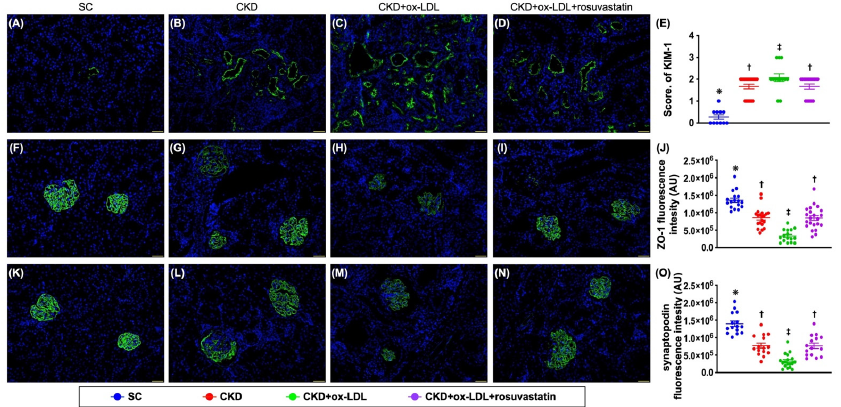
Figure 10. The histopathological analyses of kidney injury molecule and podocyte components in kidney parenchyma by day 42 after CKD induction. ( A – D ) Illustrating the immunofluorescent (IF) microscopic finding (200×) for identification of cellular expressions of kidney injury molecule (KIM)- 1 (green color). ( E ) Analytical result of the expression of KIM-1, * vs. other group with different symbols (†, ‡), p < 0.0001. ( F – I ) Illustrating the IF microscopic finding (200×) for identification of cellular expressions of ZO-1 (green color). ( J ) Analytical result of expression of ZO-1, * vs. other group with di ff erent symbols (†, ‡), p < 0.0001. ( K – N ) Illustrating the IF microscopic finding (200×) for identification of cellular expression of synaptopodin (green color). ( O ) Analytical result of ex- pression of synaptopodin, * vs. other group with di ff erent symbols (†, ‡), p < 0.0001. Scale bars in right lower corner represent 50 μ m. All statistical analyses were performed by one-way ANOVA, followed by Bonferroni multiple comparison post hoc test (n = 6 for each group). Symbols (*, †, ‡) indicate significance for each other (at 0.05 level).